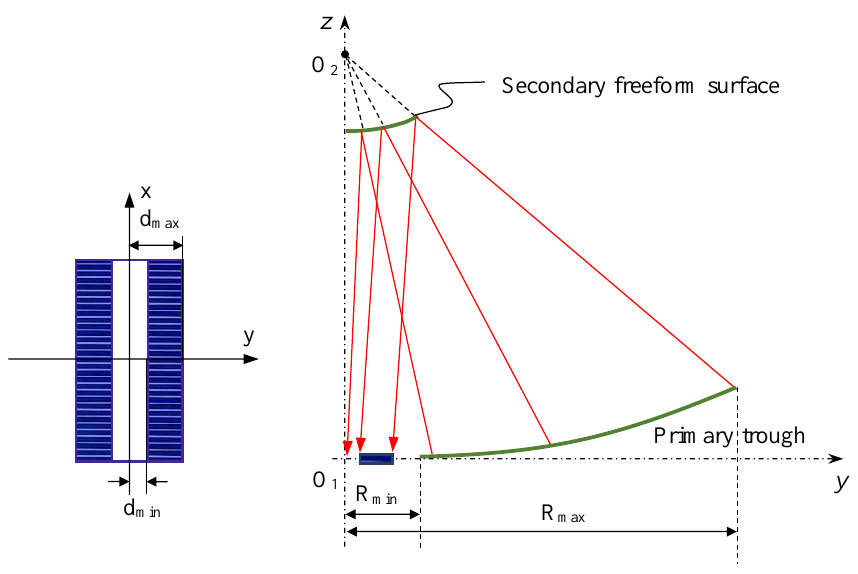
Figure 2. Sketch of the TFSC structure and rim ray tracing. As shown in Figure 2, the optical axis of the primary trough concentrator is arranged coincident with z-axis. Origin O 1 is the parabolic center. The PV and thermal absorber are both arranged along the x-axis at z = 0. O 2 is the focus point of the primary mirror. R min and R max are the inner and outer widths of the primary trough concentrator, respectively.